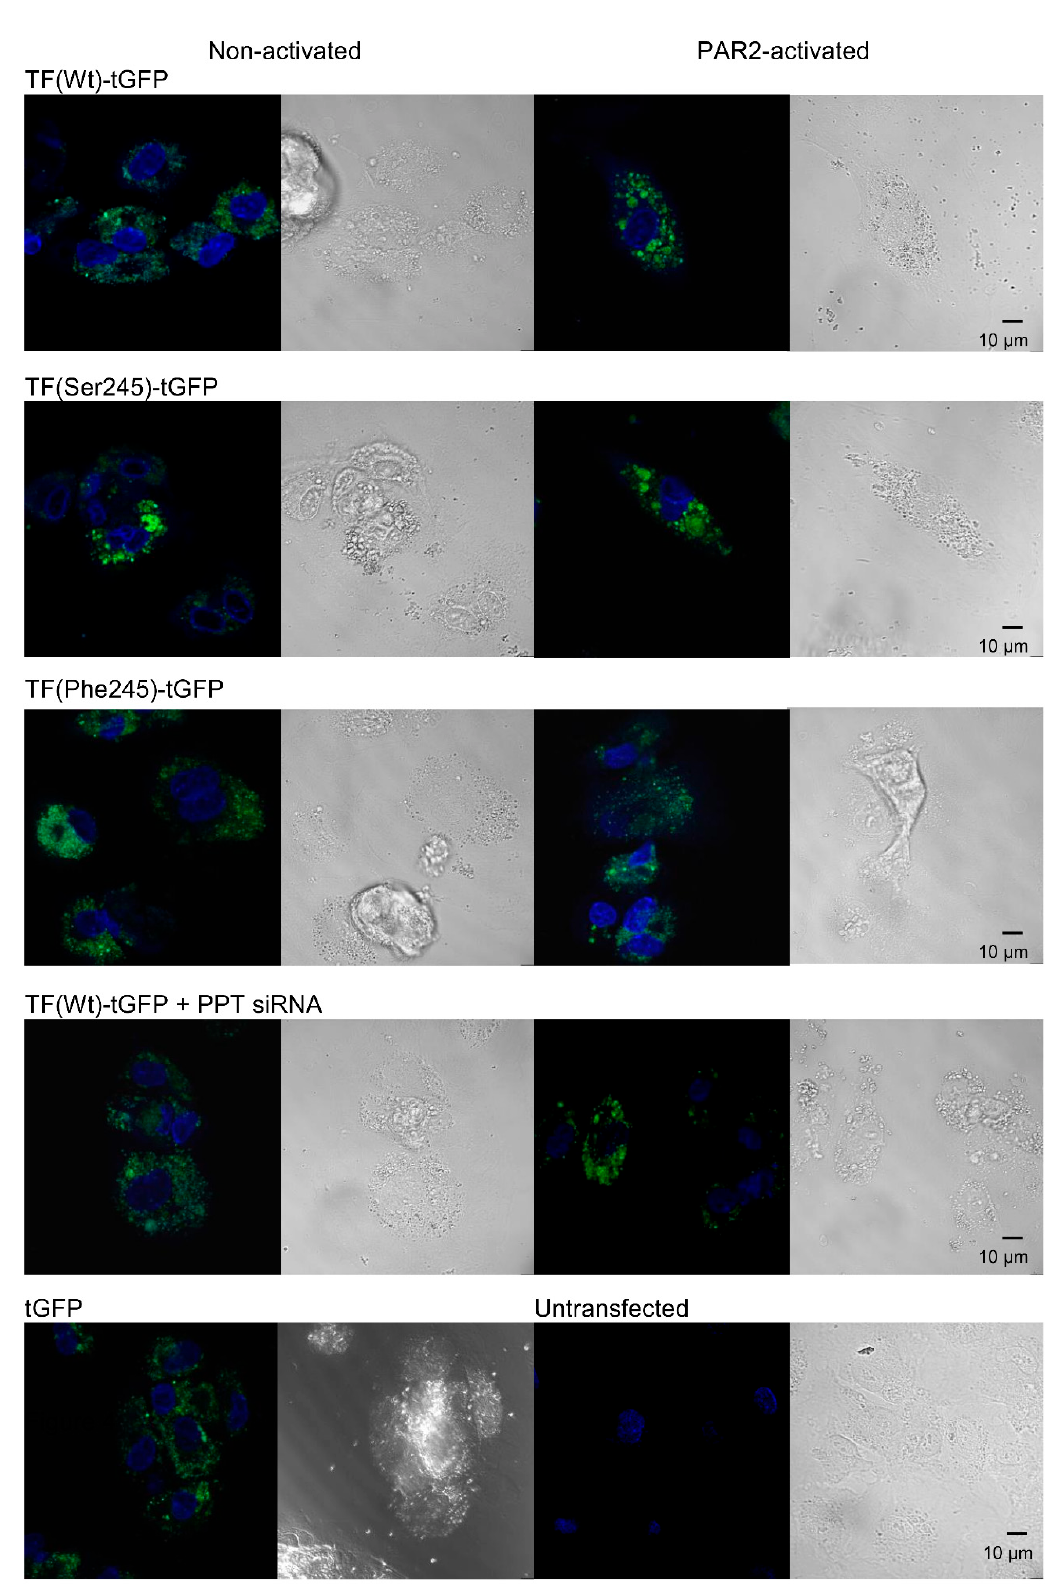
Figure 3. Confocal microscopy analysis of TF-tGFP distribution within cells. HDBEC (5 × 10 4 ) were transfected to express TF Wt -tGFP in the presence and absence of PPT-siRNA or to express TF Ser245 -tGFP or TF Phe245 -tGFP. Sets of cells were then activated using PAR2-AP (20 µM), washed and fixed with 3% ( v / v ) formaldehyde. All cells were labelled with DAPI and analysed using a Zeiss LSM 710 confocal microscope.